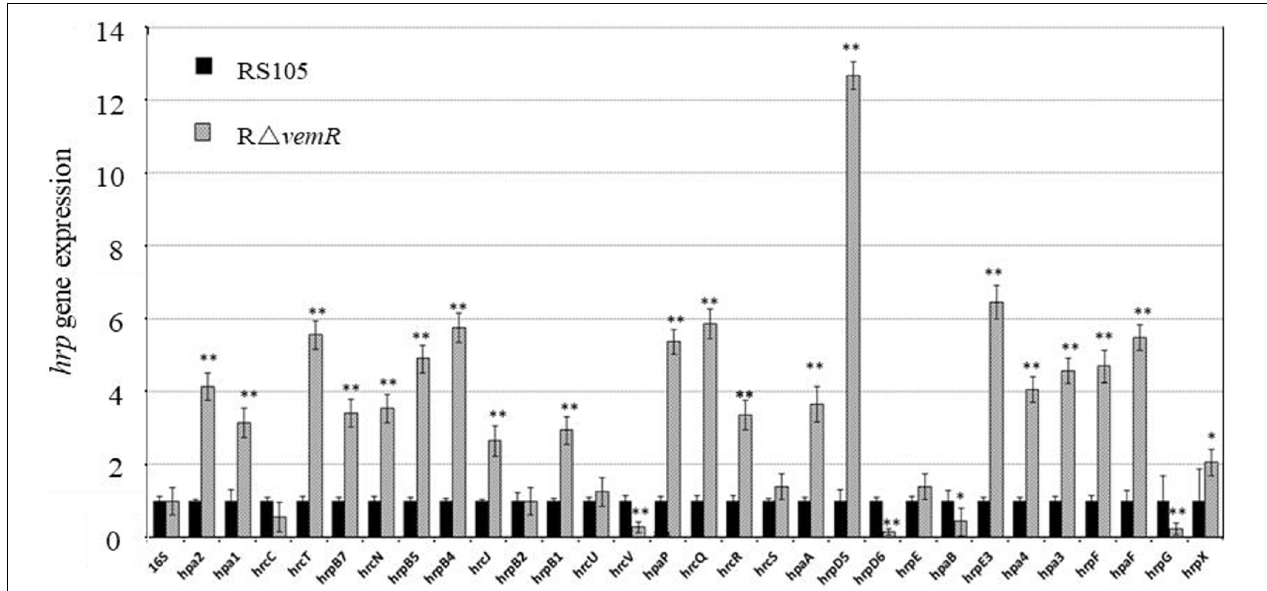
FIGURE 7 | hrp gene expression in X. oryzae pv. oryzicola ( Xoc ) is regulated by vemR . Xoc wild-type RS105 and the deletion mutant strain R (cid:49) vemR were induced in XOM3 medium for the expression analysis of the hrp genes. The comparative-threshold method was used to calculate the relative transcript abundance with respect to the corresponding transcript in the RS105 strain. The expression level of the 16S rRNA gene was used as an internal control. Student t -test ( p = 0.01 and 0.05) was used to separate significantly different means denoted by ** and *, respectively.